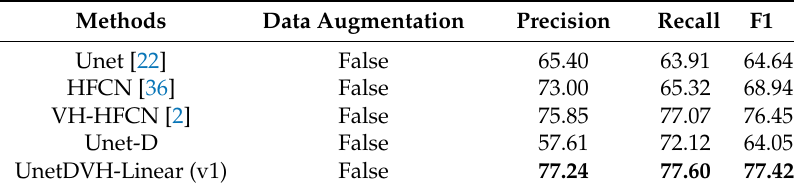
Table 10. Performance of road extraction in Massachusetts Roads Dataset by our method and other models with the same training settings